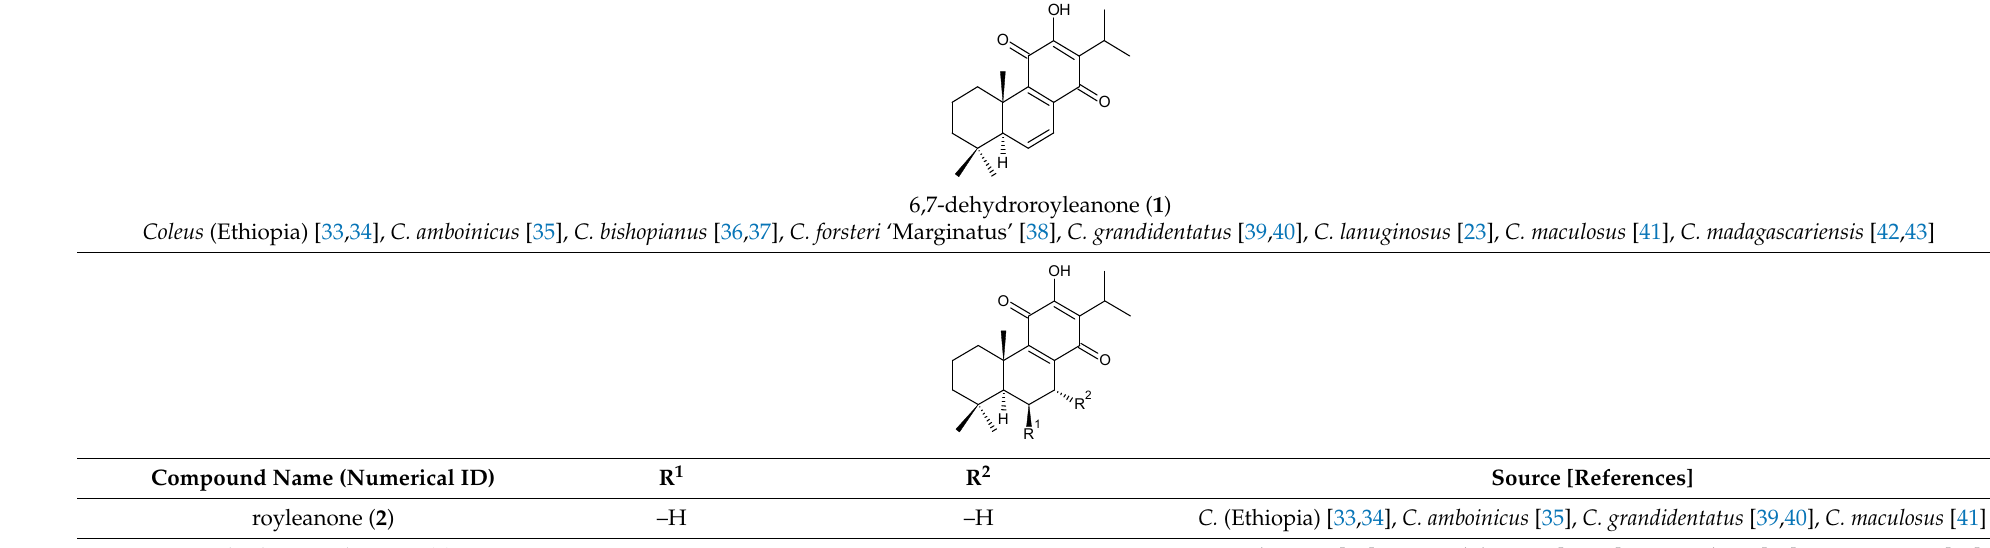
Table 1. Royleanones of the genus Plectranthus s.l. (a) Royleanones with an Isopropyl Side Chain